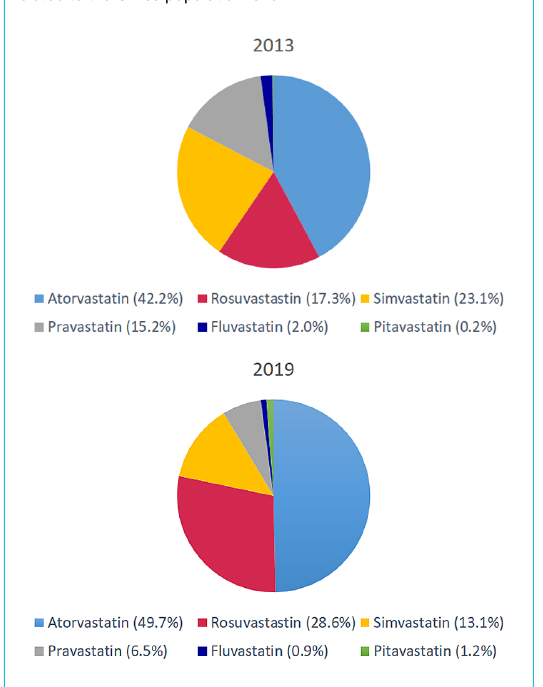
Figure 3: Filled prescriptions of statins in the years 2013 (n = 2,030,703) and 2019 (n = 2,494,695), by active substance, extrap- olated to the Swiss population level.